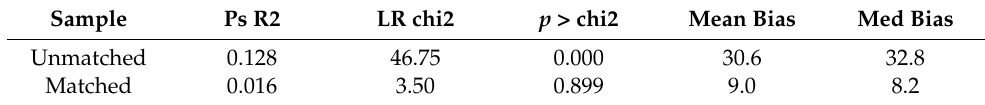
Table 4. Overall evaluation of matching results.